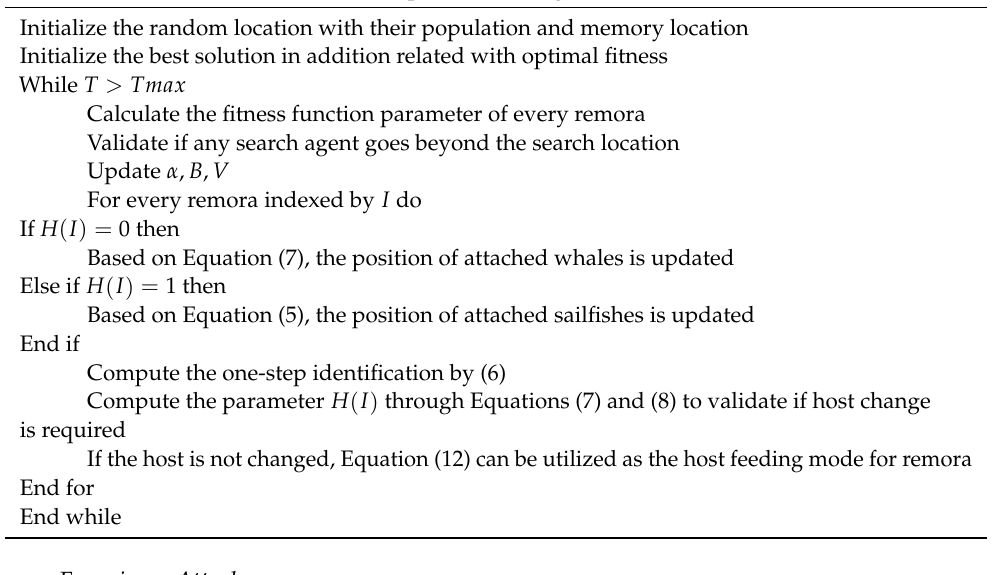
Algorithm 1: Pseudocode of Remora Optimization